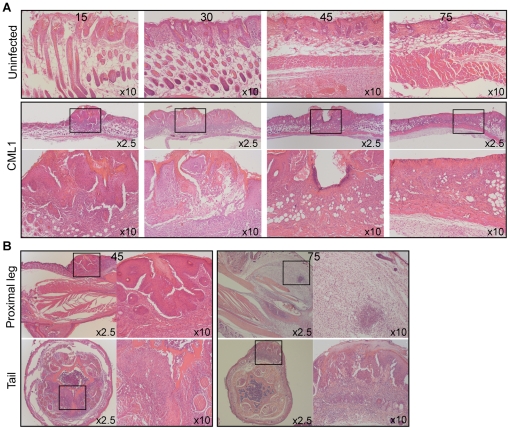
Histology of back skin (scarified-zone), proximal leg and tail in nu/nu infected by scarification with CML1.(A) Hematoxylin and eosin-stained skin tissues are shown for uninfected and CML1-scarified nu/nu mice at 15, 30, 45 and 75 dpi. Inflammation is centered around hair follicles, as well as in the deep muscle, and the hyperplastic epithelium invaginates to form a crater. (B) Histological examinations of proximal leg and tail of CML1-scarified nu/nu mice are shown at 45 and 75 days after virus infection. Note the epithelial hyperplasia and ulceration in the skin of the leg and of the tail, and the massive edema that extends between individual muscle fibers of the leg at 75 dpi. Magnifications are indicated on each panel, and the 10× images represent the boxed region of the corresponding 2.5× image.